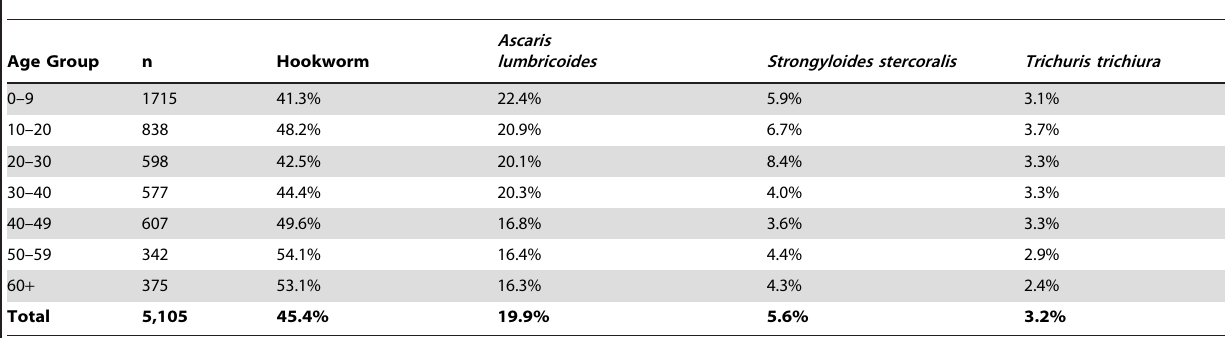
Table 4. Tsimane helminth prevalences by age